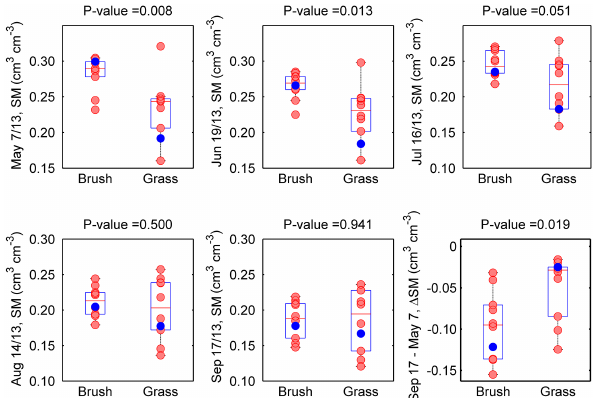
Figure 7. Variability of soil moisture storage for the two different vegetation groups shown by box and whisker plot, with the p value from t test indicating the chance of similar means. The number of grass and brush locations are both 10. Blue dots indicate the chosen grass and brush monitoring sites (60A and 150C,